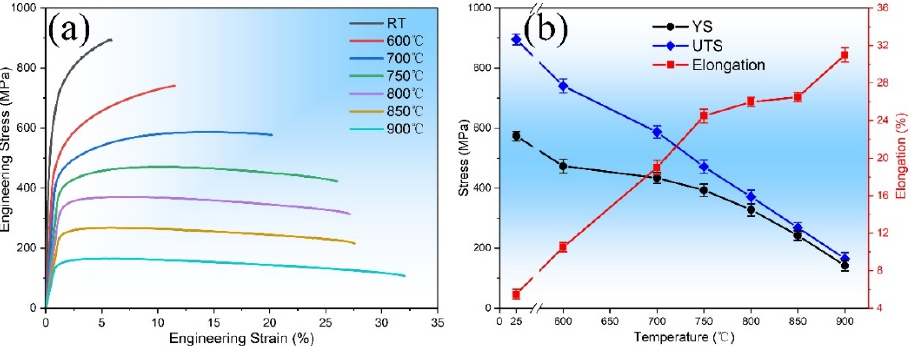
Figure 3. ( a ) Engineering stress-strain curves of the HEA at different temperatures, ( b ) temperature dependence of the yield strength (YS), ultimate tensile strength (UTS) and elongation of the HEA tested at a strain rate of 10 − 3 s − 1 .